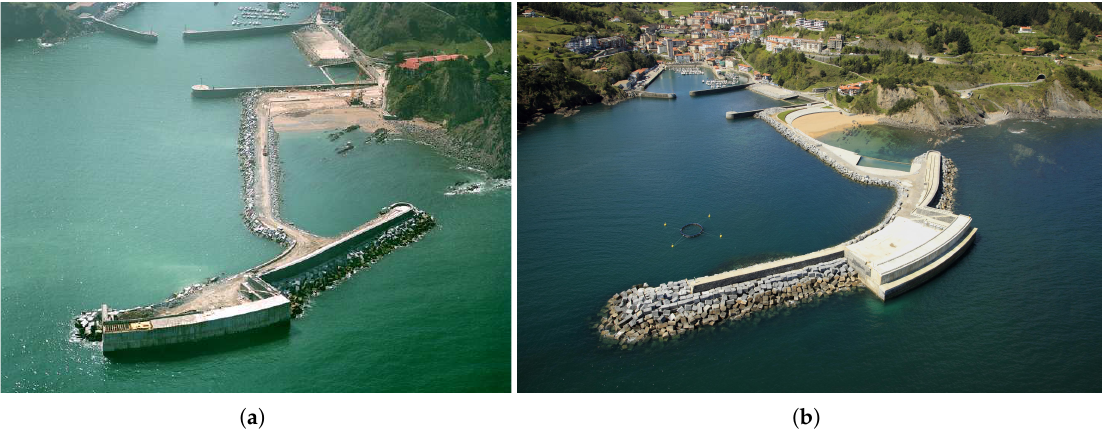
Figure 4. Bird´s eye view of the breakwater - Spring-2008 Figure 2. Comparison between the original and the present-day design of the integrated breakwater-OWC system in Mutriku. ( a ) View of the MWEP in 2008 (Reproduced with permission from [6]). ( b ) Mutriku OWC (source: EVE